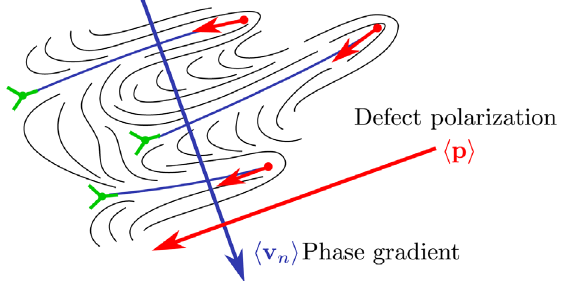
FIG. 2. Structure of the polar defect-ordered state for extensile activity ( v < 0 ). The spontaneous polar ordering of the þ 1 = 2 defects combined with their active self-propulsion leads to a spontaneously flowing defect liquid. The nonvanishing average defect polarization ( h p i ≠ 0 ) simultaneously forces a nonvanish- ing phase gradient ( h v n i ≠ 0 ) to condense in the orthogonal direction, which leads to a periodic array of kink walls (also called π or N´eel walls) in the underlying nematic, with each kink wall (blue lines) terminating at the þ 1 = 2 (red) and − 1 = 2 (green)